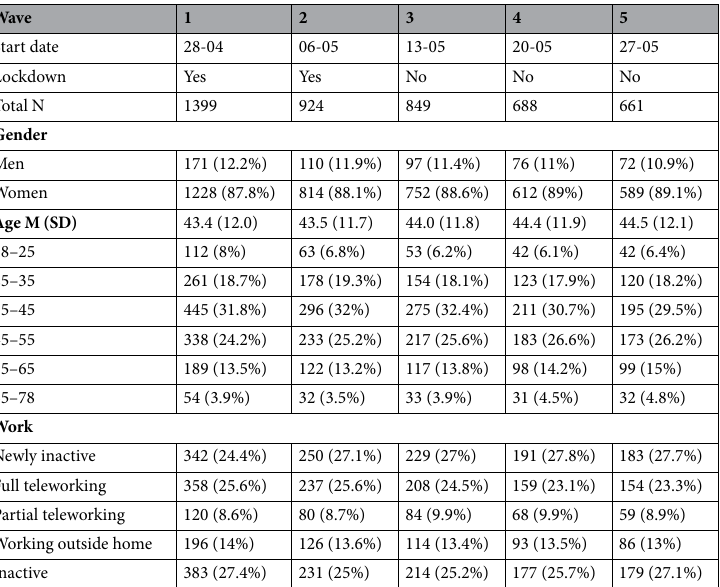
Table 1. Sociodemographic characteristics of participants in each wave. Wave 1 corresponds to the initial measurement time; waves 2 to 5 are weekly follow-ups. Each participant responded to at least two waves (including wave